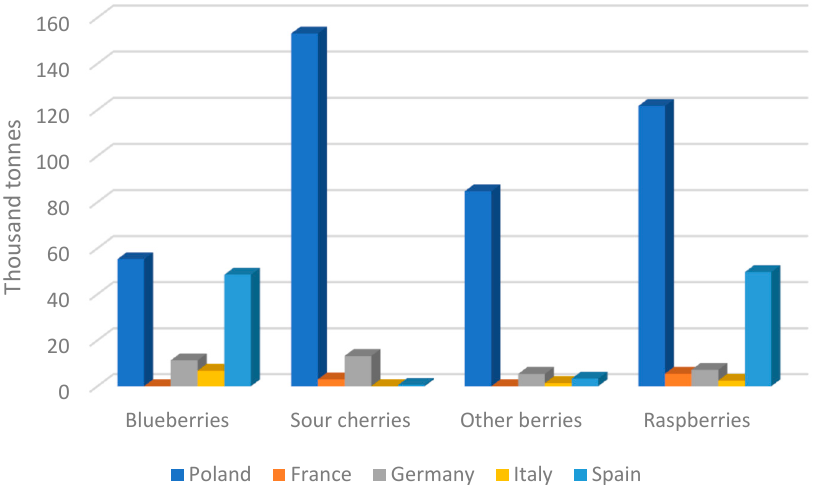
Figure 6. European fruit production in 2020 (data from fao.org) (accessed on 12 October 2022) .